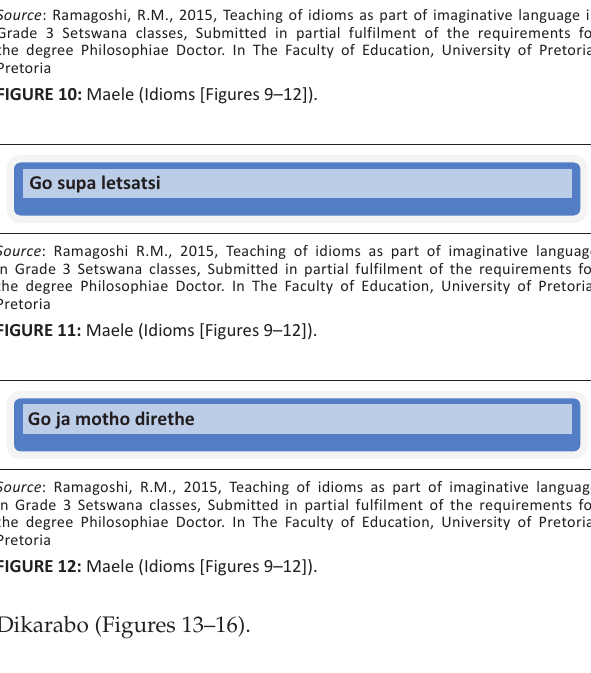
FIGURE 17: Idiom activity.